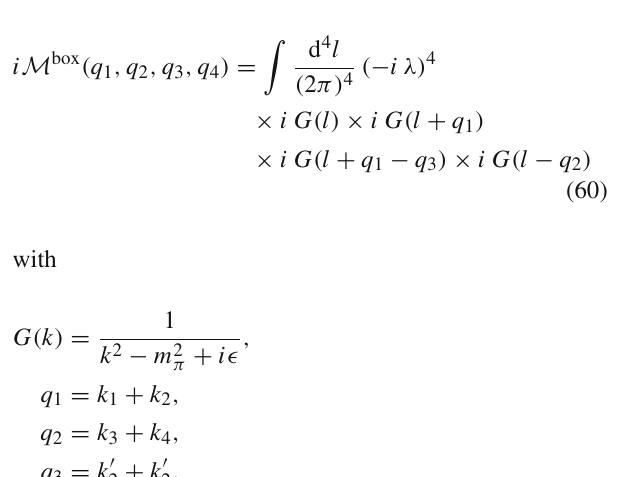
Fig. 5 Set up of the box